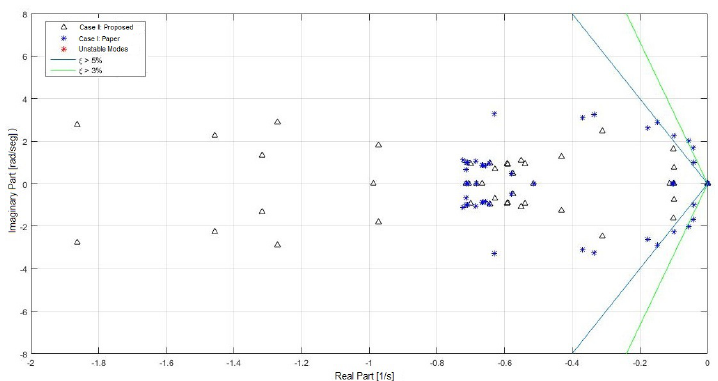
Figure 21. Eigenvalues system III.